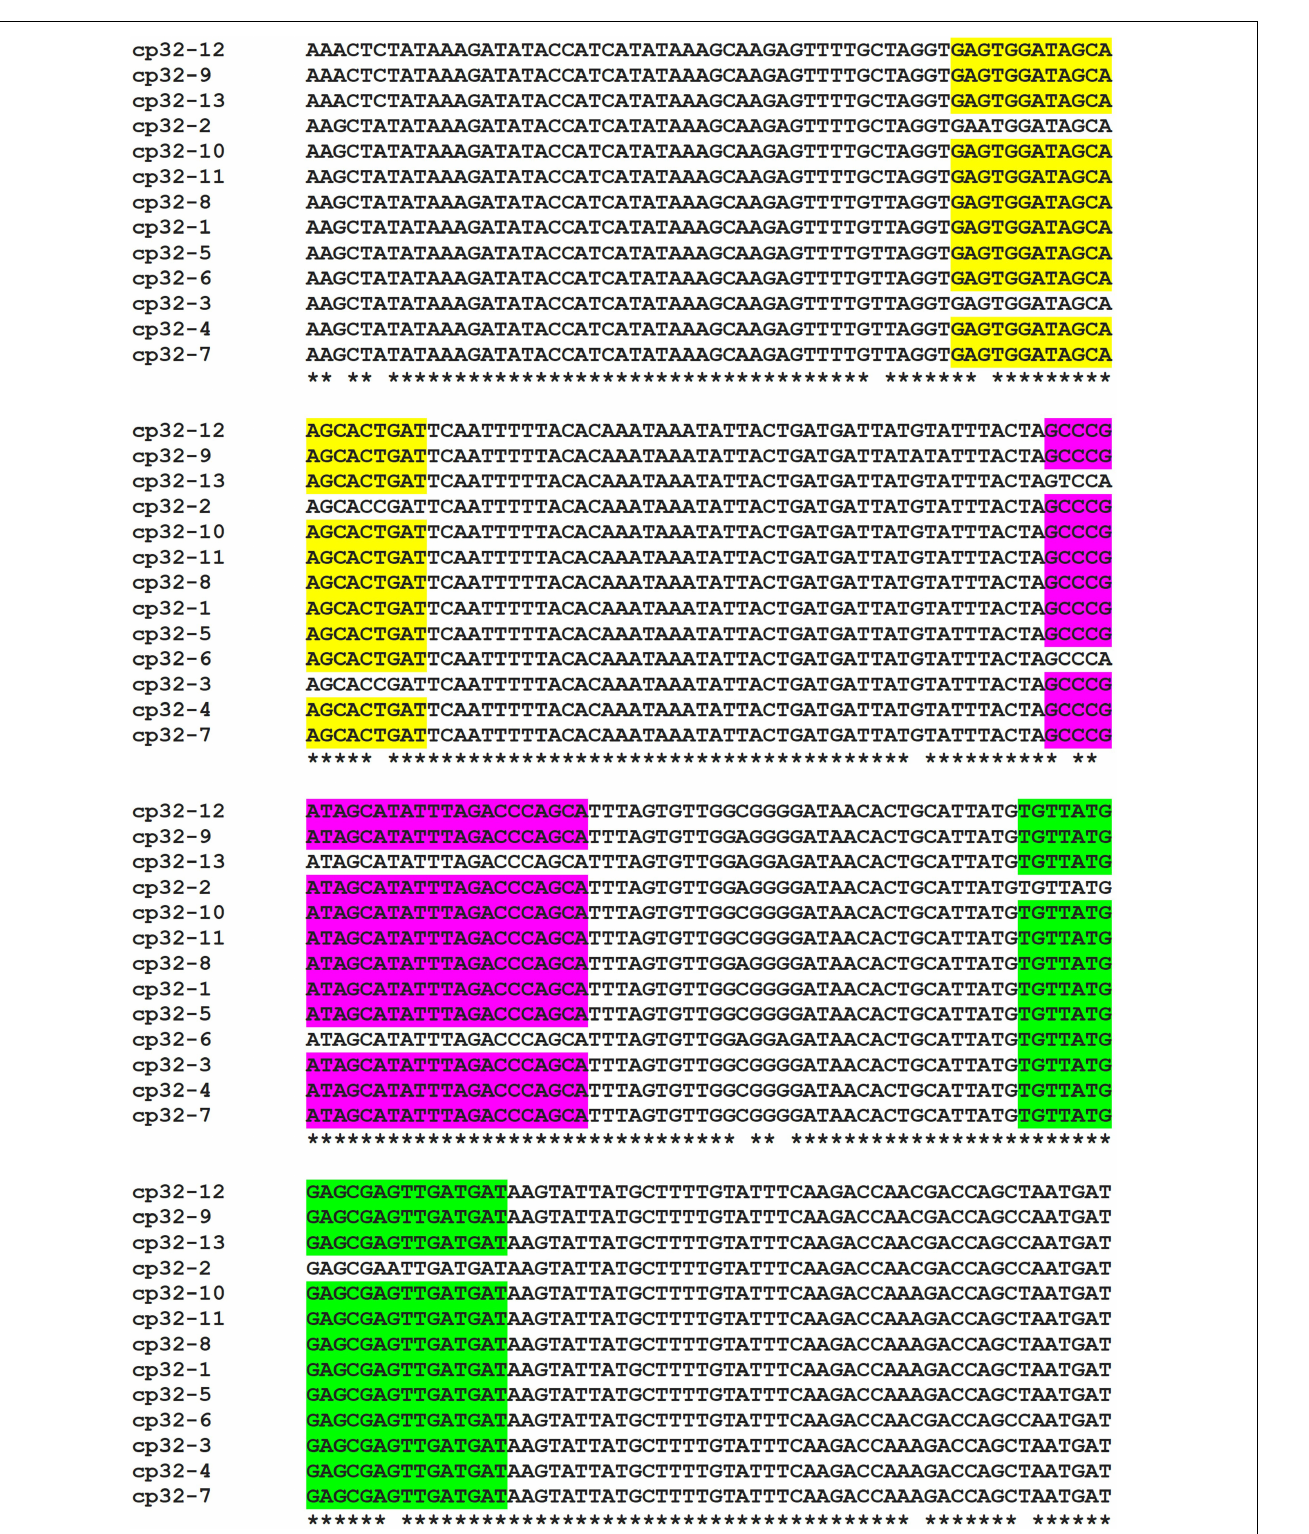
Frontiers in Microbiology |